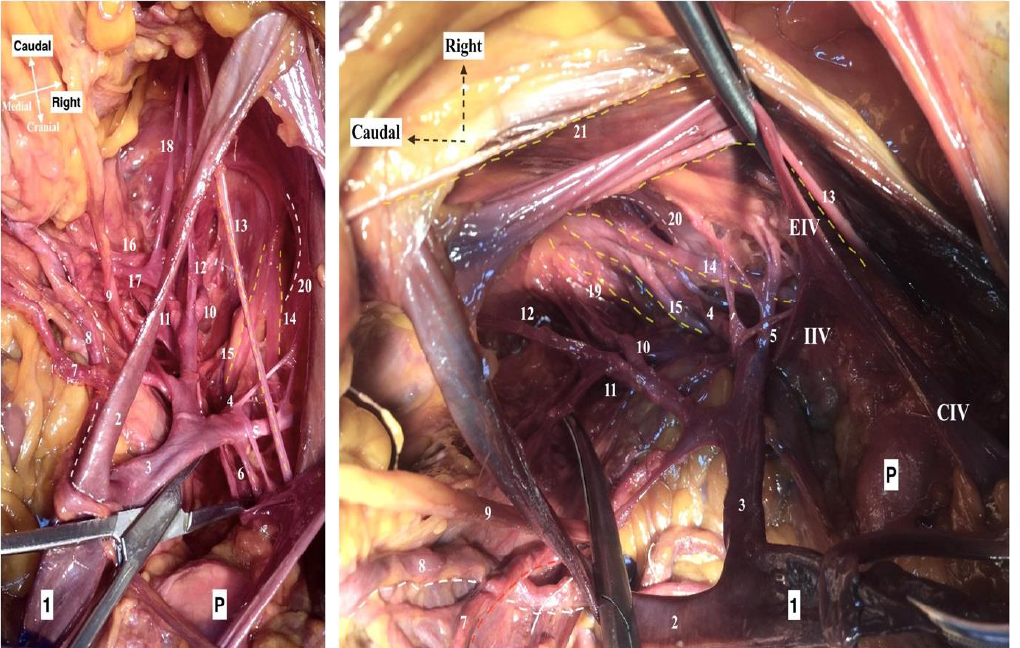
Figure 7 . Vascular region of the right pelvic sidewall (cadaveric dissection by Dr. Ilker Selcuk). 1.